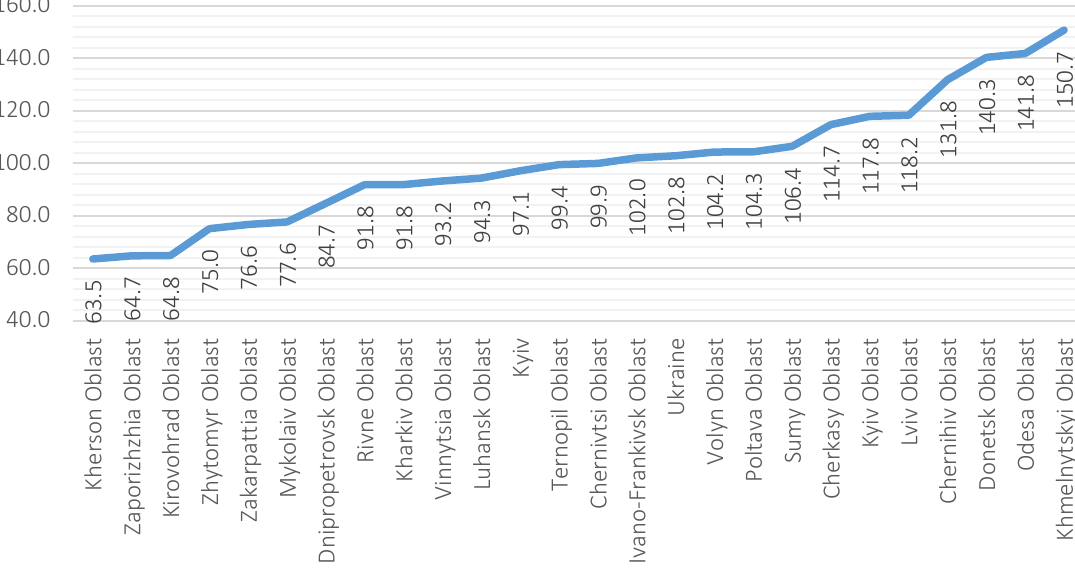
Figure 4. Dynamics of construction in 2020: interregional